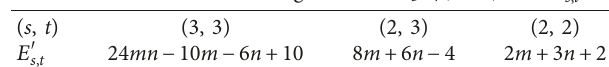
Figure 3: The edge partition of the nanosheets (a) VC different E s,t and (b) VC 5 C 7 (2, 4) by different E s,t Table 3: Partition of the edge set of HC